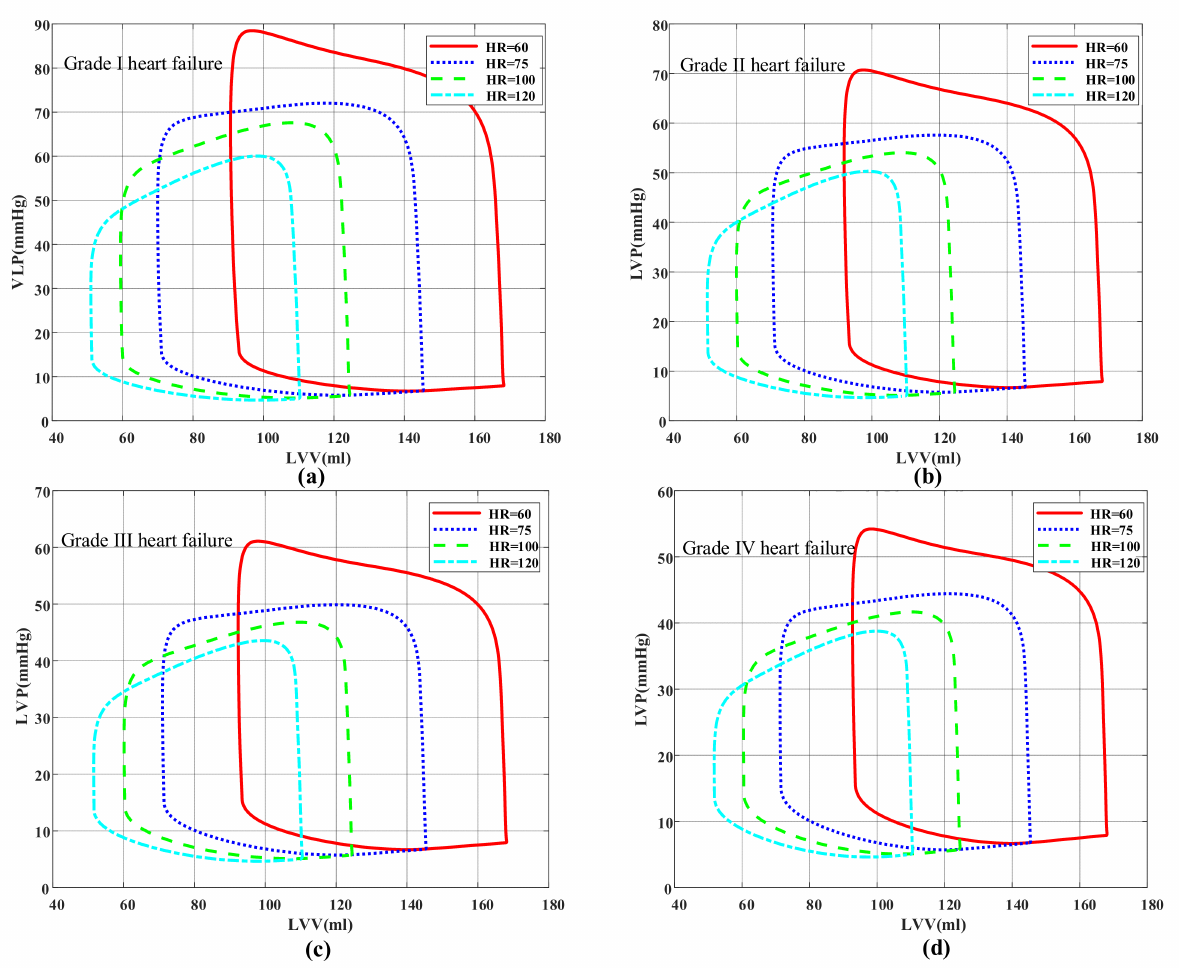
Figure 10. Pressure–volume loop. ( a ) Grade I heart failure (E max = 1.05), ( b ) Grade II heart failure (E max = 0.83), ( c ) Grade III heart failure (E max = 0.713), ( d ) Grade IV heart failure (E max =